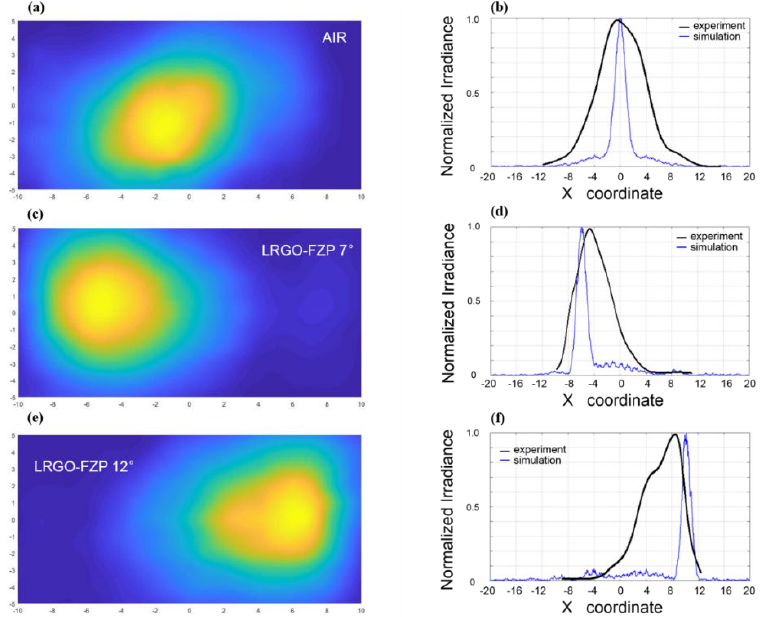
Figure 4. Measured THz field distributions on the focal plane, corresponding to the FZPs with air and different deflections of ( a ) air ( c ) 7 ◦ , and ( e ) 12 ◦ . Measured field-intensity distribution of the X-axis on the focal plane, corresponding to the FZPs with air and different deflections of ( b ) air, ( d ) 7 ◦ , ( f ) 12 ◦